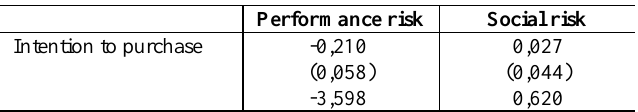
Table 2: Brand knowledge as intervening variable: Partial mediation